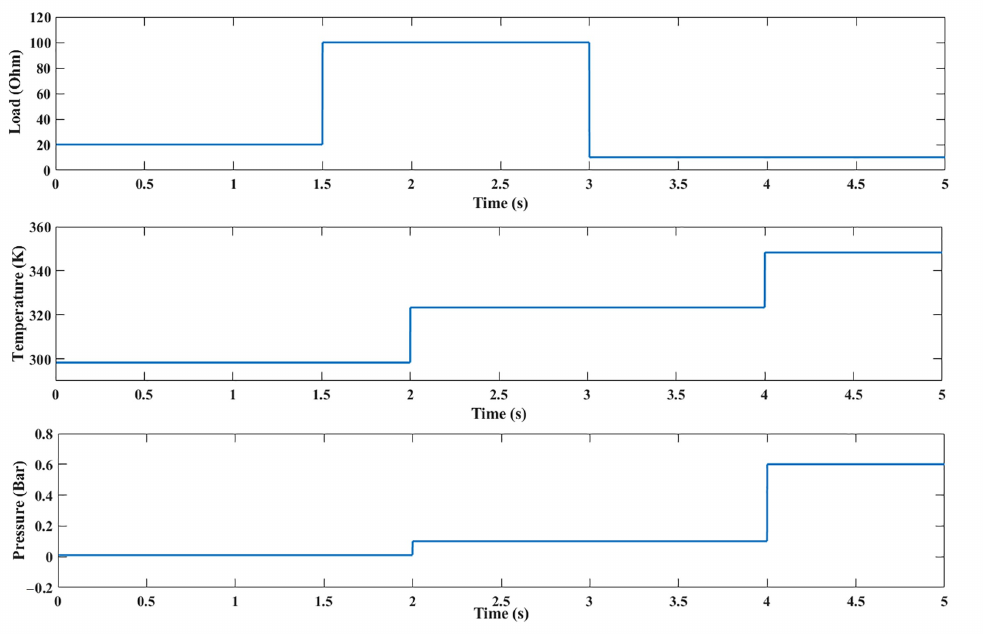
Figure 8. ( Top ) Resistance; ( middle ) Temperature; ( bottom ) Hydrogen gas